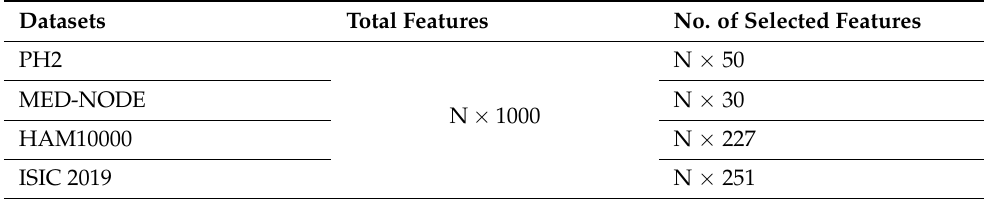
Table 3. Selected numbers of features in each dataset.